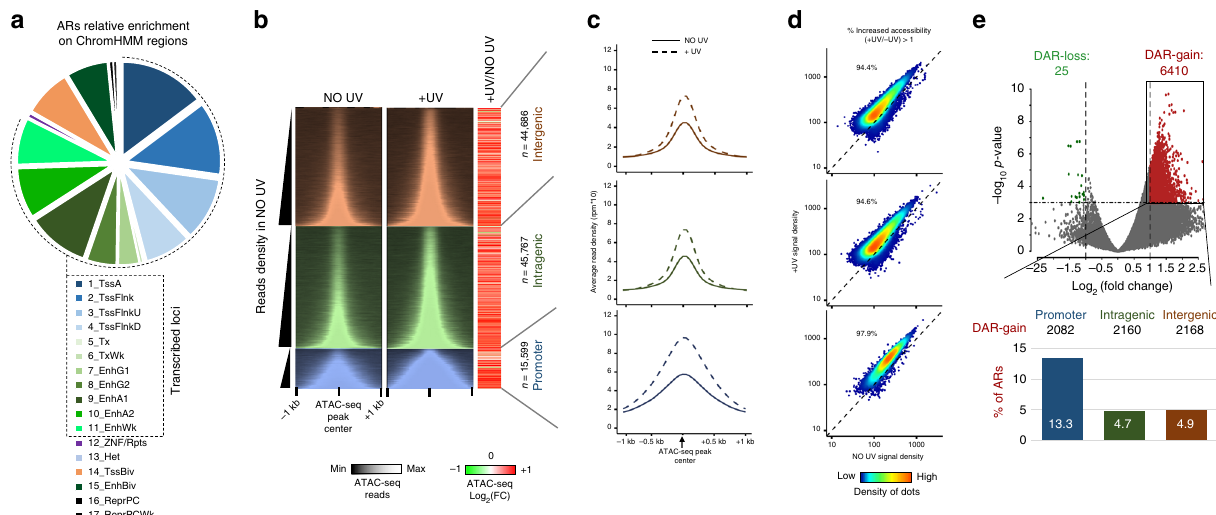
Fig. 1 Increase in chromatin accessibility in response to mild doses of UV irradiation. a Classi fi cation of ARs according to ChromHMM annotation. The dashed line represents active regulatory loci. b (Left panel) Heatmap of ATAC-seq reads in genomic regions 1 kb around ATAC-seq peak centers before (NO UV) and after UV ( + UV, + 2 h; 15 J/m 2 ), categorized according to their genomic position relative to RefSeq genes (intergenic, intragenic, and promoter peaks) and sorted by increasing read density (as determined before UV). (Right panel) Heatmap showing the log 2 fold change (log 2 FC) between + UV and ΝΟ UV read densities calculated in genomic regions 1 kb around ATAC-seq peak centers. c Average pro fi le plots of ATAC-seq read densities of non-irradiated (solid line) and irradiated (dashed line) cells in intergenic (red), intragenic (green), and promoter (blue) regions. d Heat-density scatter plots comparing ATAC-seq read density before and after UV at all accessible regions (ARs) in intergenic, intragenic, and promoter regions, respectively. e (Upper panel) Volcano plot representing differentially accessible regions (DARs) between irradiated and non-irradiated cells. Regions with signi fi cantly increased (DAR-gain) or decreased (DAR-loss) accessibility are depicted in red and green, respectively. (Bottom panel) Proportion of DAR-gain loci in intergenic, intragenic, and promoter